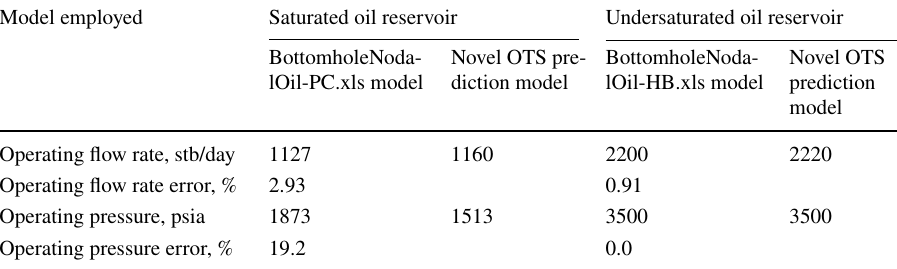
Fig. 9 IPR curve of an undersaturated oil reservoir and TPR curve for 1.995-inch tubing Table 3 Error percent